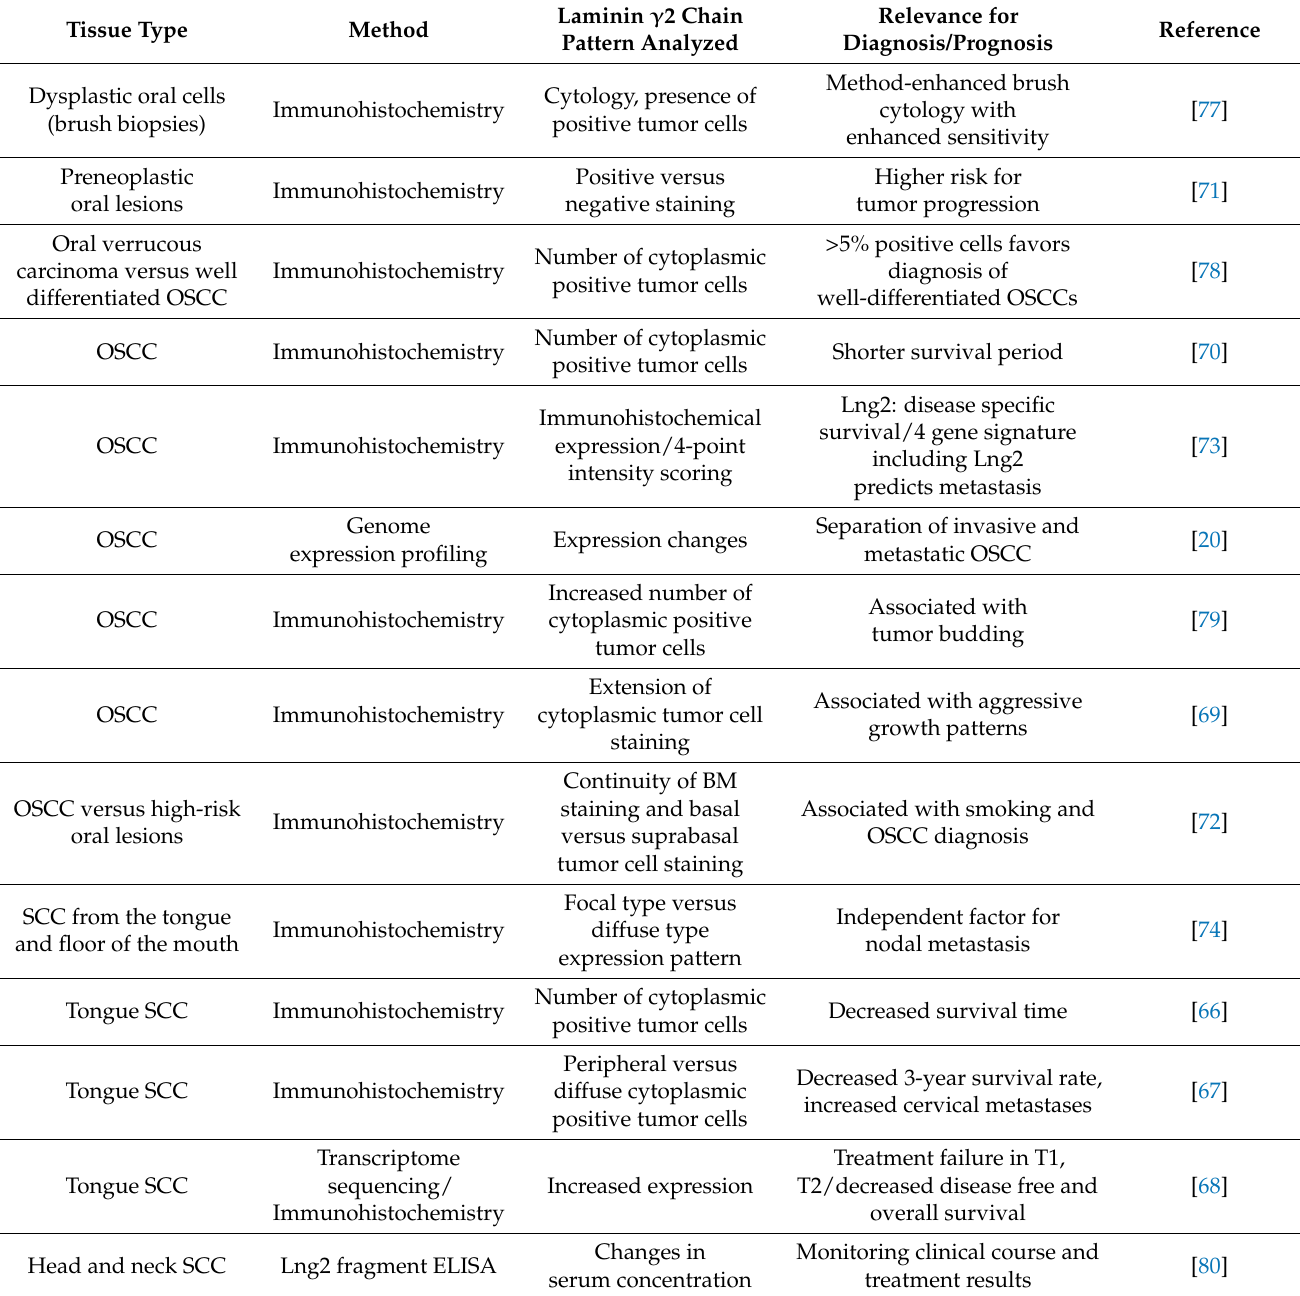
Table 1. Overview of studies conducted to assess the diagnostic and prognostic value of the laminin γ 2 chain expression pattern in oral squamous cell